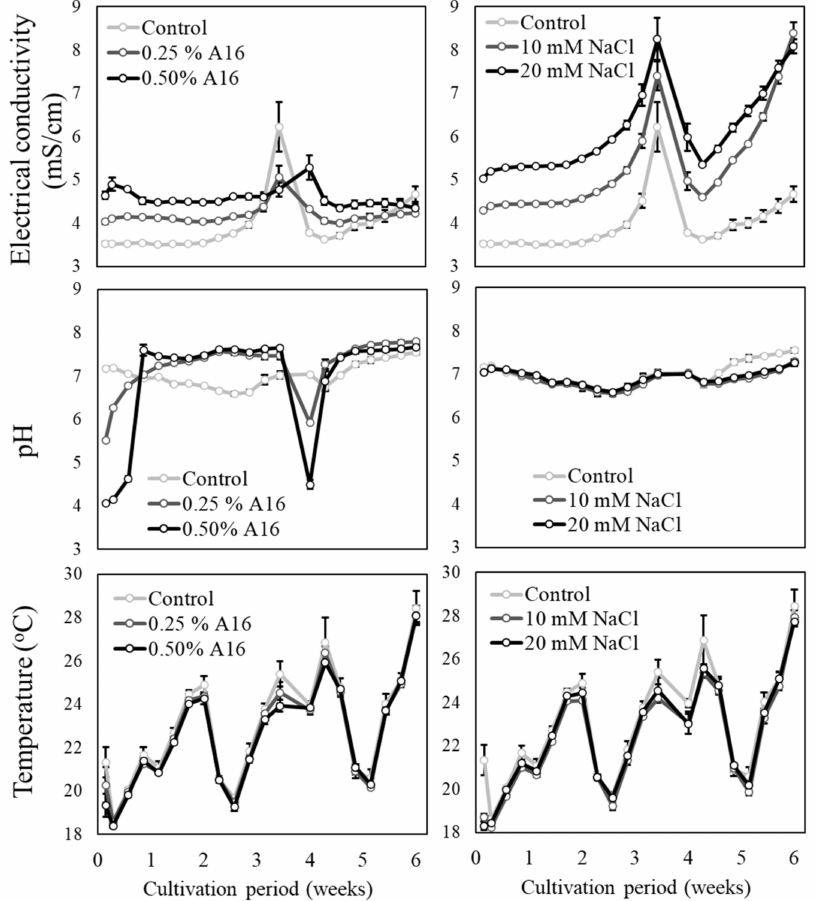
Figure 1. Electrical conductivity, pH, and temperature in the nutrient solution of the hydroponic cultivation of peppermint and spearmint plants grown after supplemented with either 0, 0.25, or 0.50% of a commercial amino acid solution (Amino16 ® ) or 0, 10, and 20 mM NaCl. Each line is the mean of 3 replications and vertical bars represent the standard errors. In each basin 45 L of nutrient solution were added at the initiation of the experiment, as well as 4 weeks